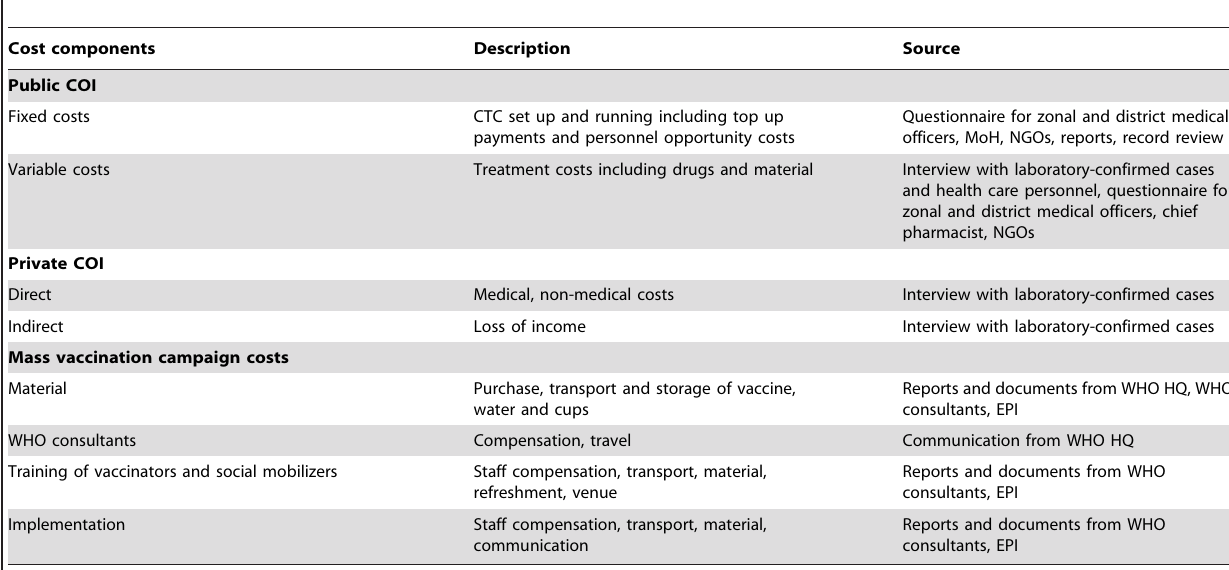
Table 1. Cost components for cholera collected in Zanzibar,